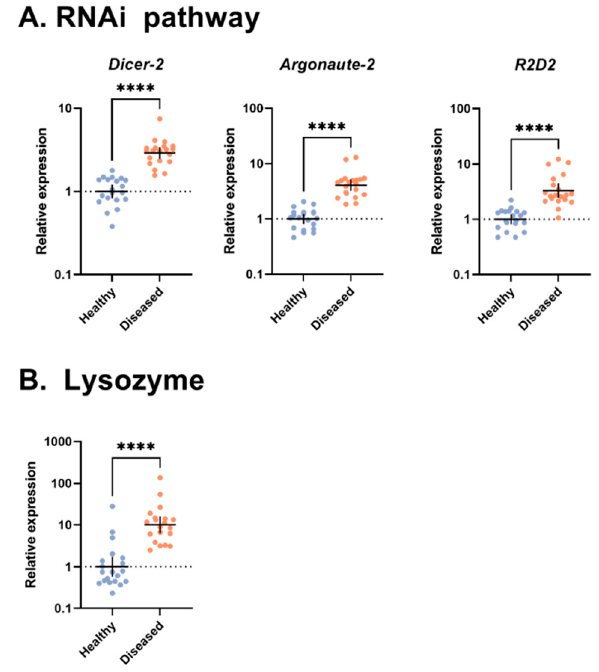
Figure 3. Gene expression profiles of ( A ) the RNAi pathway and ( B ) lysozyme in the whole bodies of Gryllodes sigillatus adults from two populations (sample size: diseased n = 20, healthy n = 20). Each dot represents a single cricket with horizontal lines representing mean expression with 95% confidence intervals. The statistical significance of fold change values was determined on log 2 -transformed values via unpaired t -test with Welch’s correction. **** p < 0.0001.